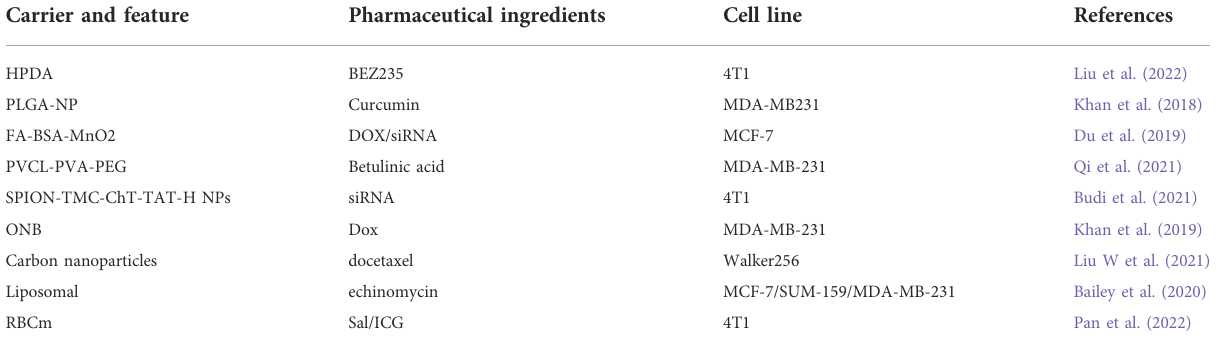
TABLE 4 Drug delivery systems for targeting HIF-1 α